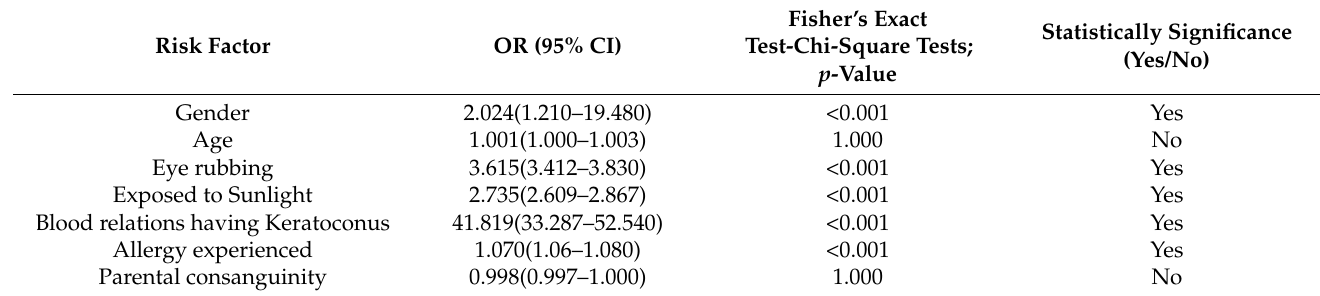
Table 2. Significance of risk factors of keratoconus associated with